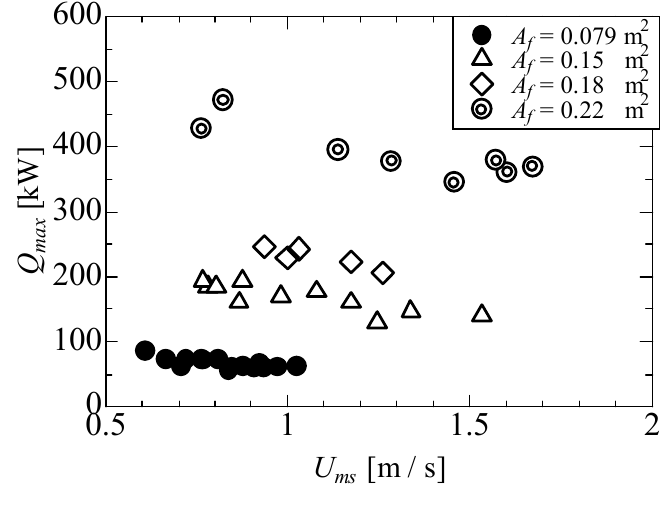
Fig. 5 Relationship between the quasi-steady heat release rate Q max and the average velocity of the longitudinal ventilation U ms in the four different burning areas A f = 0.079, 0.15, 0.18, and 0.22 m